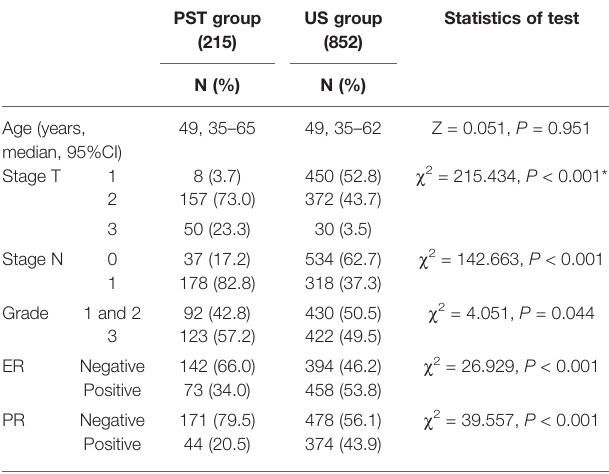
TABLE 1 | The clinicopathologic characteristics of two groups.